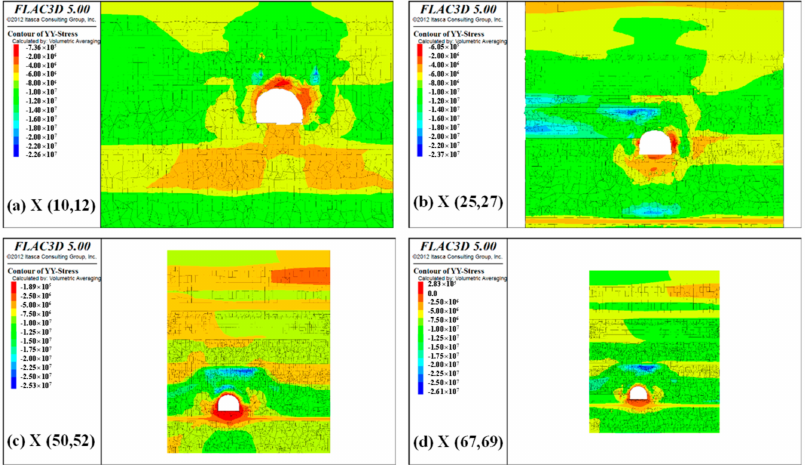
Figure 10. Y − direction stress distribution of the four monitoring areas without excavation distur-